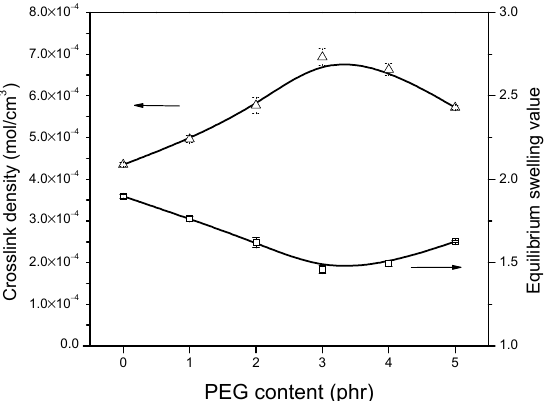
Figure 8. Crosslink density and equilibrium swelling value of the composites with different PEG